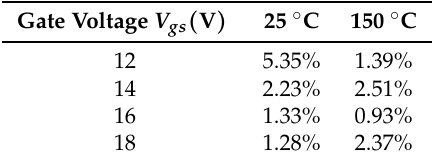
Table 4. Discrepancies between the model and measured